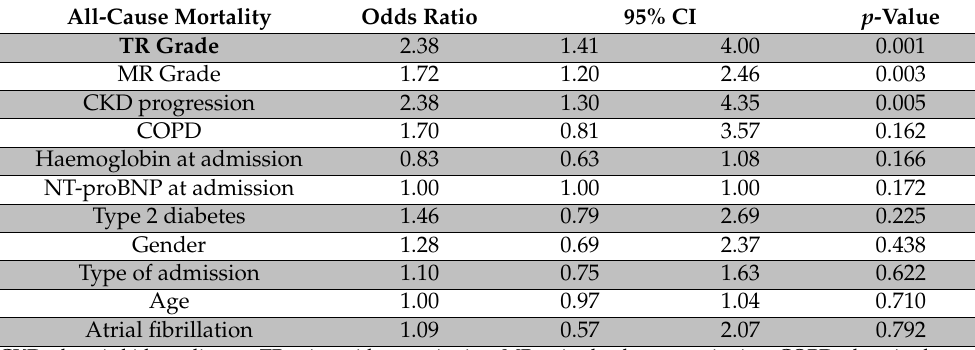
Table 2. Multivariable logistic regression analysis for all-cause mortality.